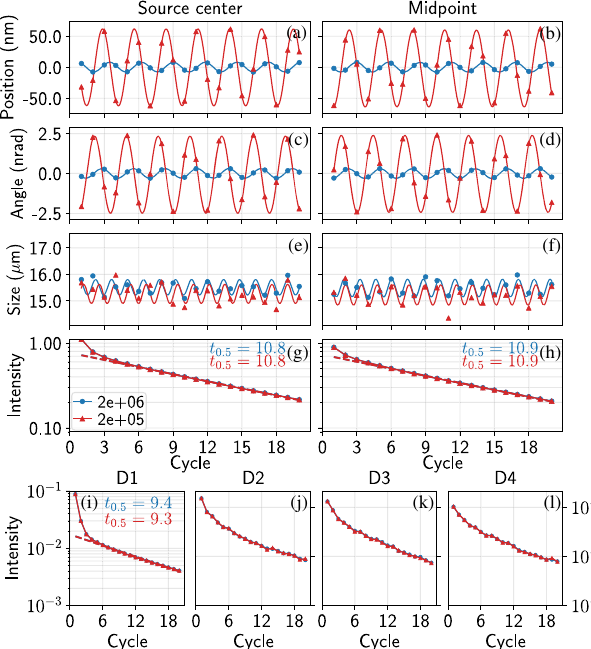
FIG. 6. Numerical simulations of x-ray beam dynamics in the perfectly aligned generic four-crystal rectangular cavity shown in Fig. 1. Values are presented simulated at cavity midpoint (top, left column), source center (top, right column), and beam intensity monitor positions (bottom row). The cavity and source param- eters are provided in Table I. Two resolutions are shown: 2 × 10 5 rays (red) and 2 × 10 6 rays (blue). The positional and angular oscillations are due to numerical simulation artifacts, as discussed in the text. See text for